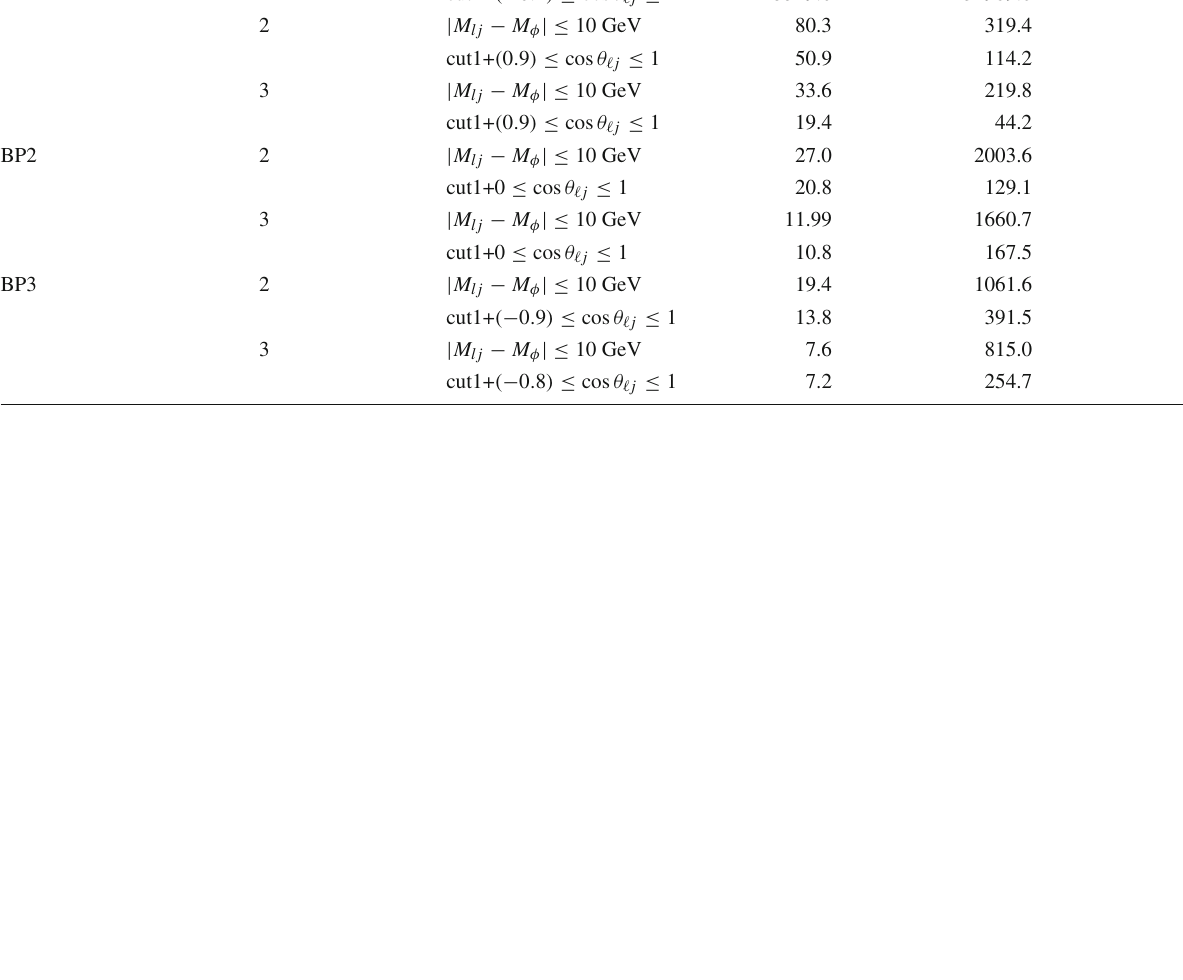
Table 7 Signal-background analysis for leptoquark ( (cid:19) R + 2 Bench-mark